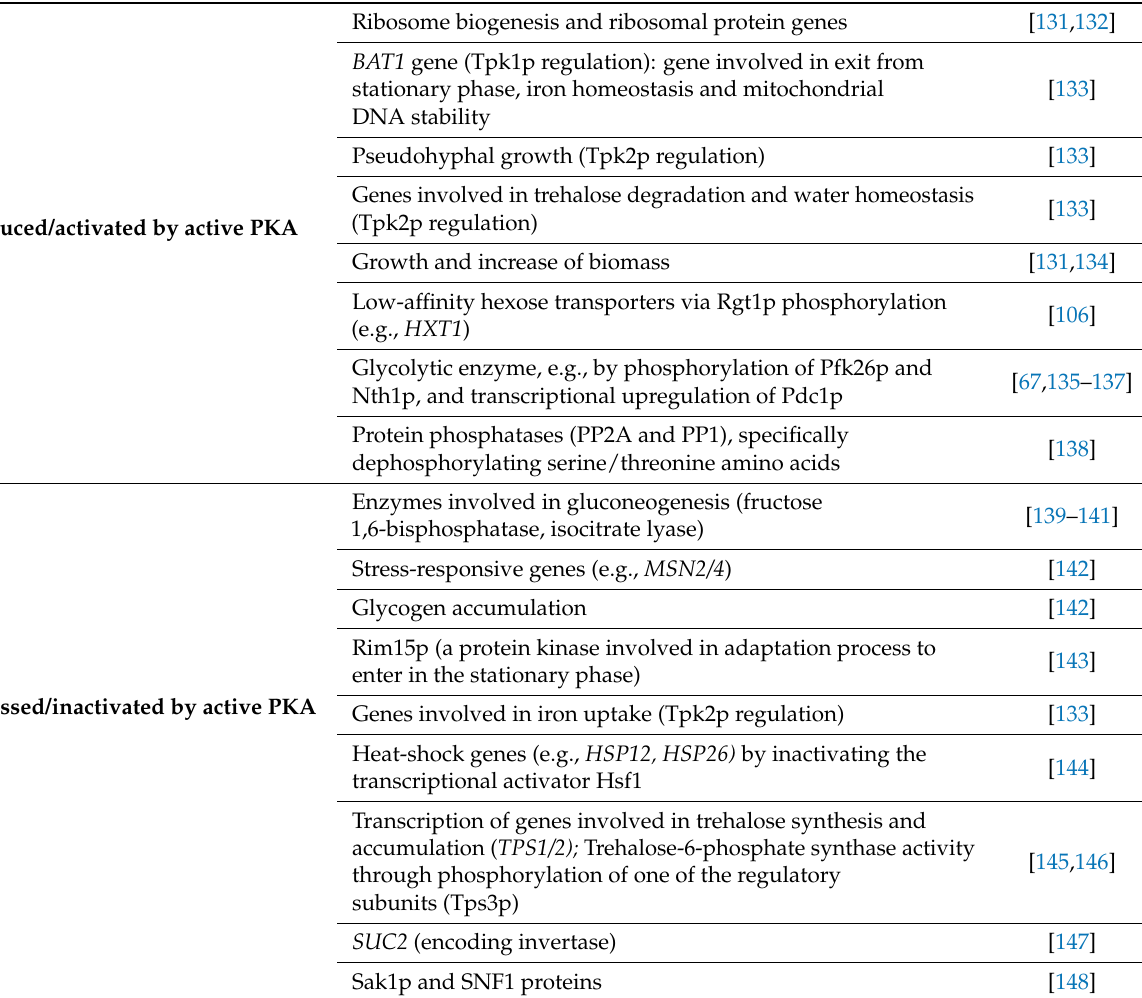
Table 2. Main metabolic and physiological effects of PKA activation. PKA is activated via sensing of extracellular D -glucose and glycolytic activity. Signaling pathway cross-talk is not covered by this table. Adapted from [78].